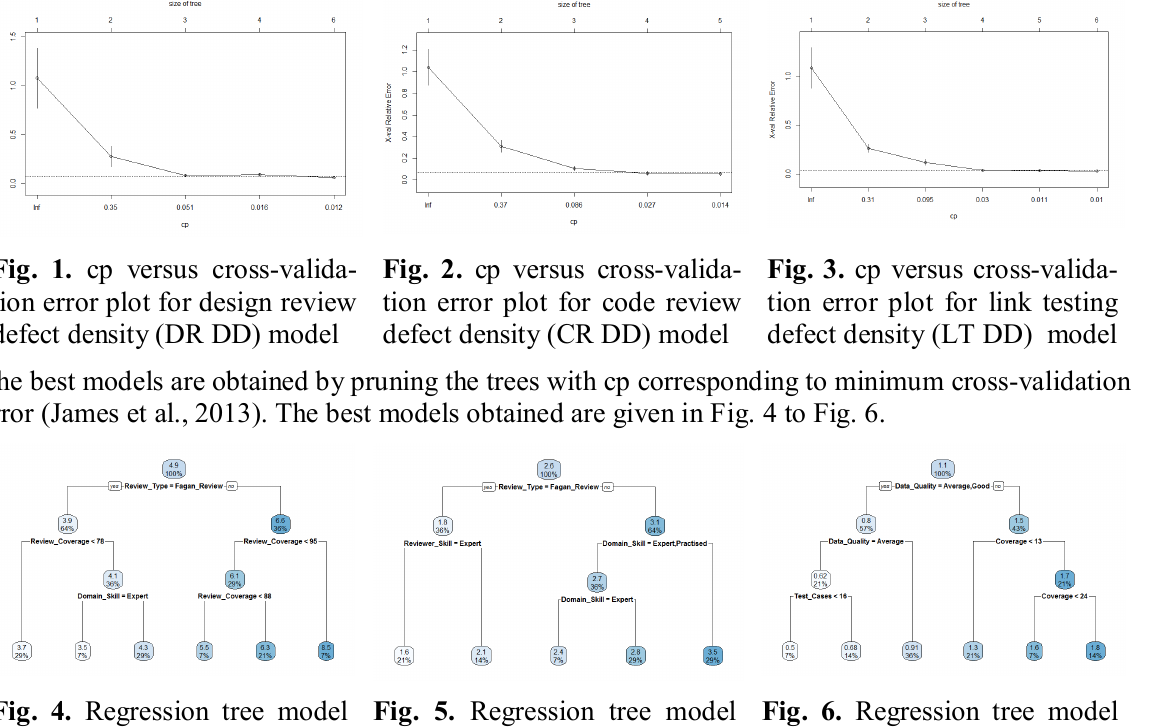
Fig. 5. Regression tree model for code review defect density